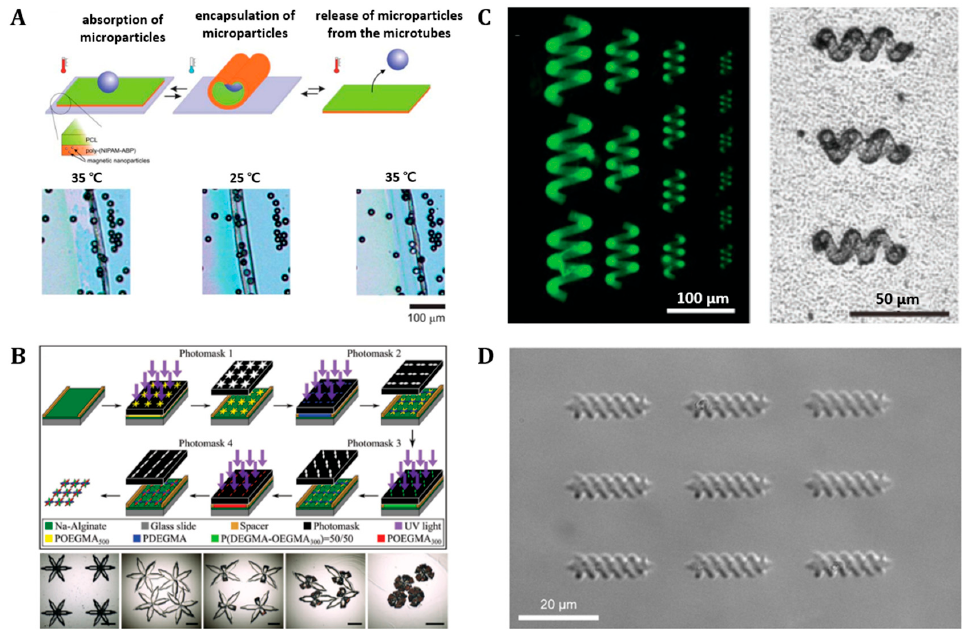
Figure 2. Microscale biorobots fabricated by photolithography and two photon polymerization processes. ( A ) Photolithography : Scheme of the capture and release of microparticles by self-rolling microtubes (upper) and images of the encapsulation and release of microparticles from microtubes at different temperatures (lower). Reproduced with permission [107]. Copyright 2010, The Royal Society of Chemistry. ( B ) Photolithography : Schematic representation of the fabrication process for four-state, thermally responsive grippers (upper) and representative images of grippers (lower). Reproduced with permission [108]. Copyright 2018, Wiley-VCH. ( C ) Two-photon lithography : Fluorescent image of helical microstructures with different sizes (left) and optical image of helical micro-swimmers decorated with magnetic nanoparticles (right). Reproduced with permission [64]. Copyright 2018, Wiley-VCH. ( D ) Two-photon lithography : Optical microscopy image of 3 × 3 array of the micro-swimmers. Reproduced with permission [32]. Copyright 2018, The American Chemical Society.